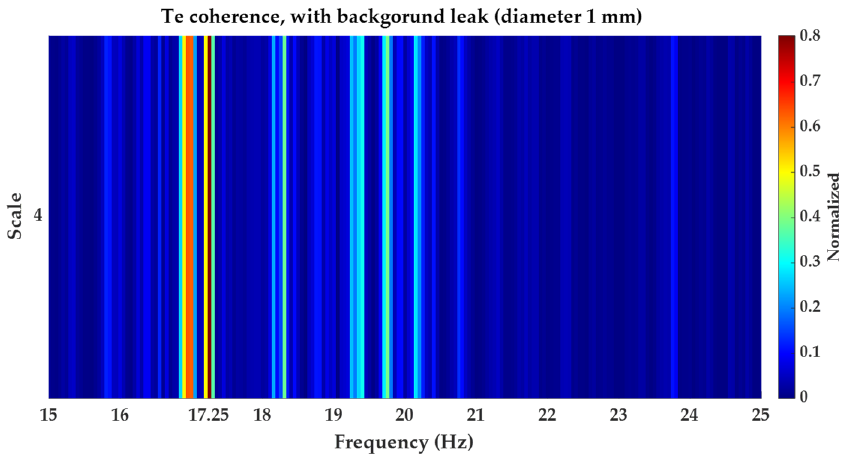
Figure 16. 𝒯 (cid:3032) coherence in Scale 4 , with background leak ( 1 mm in diameter) and flow rate